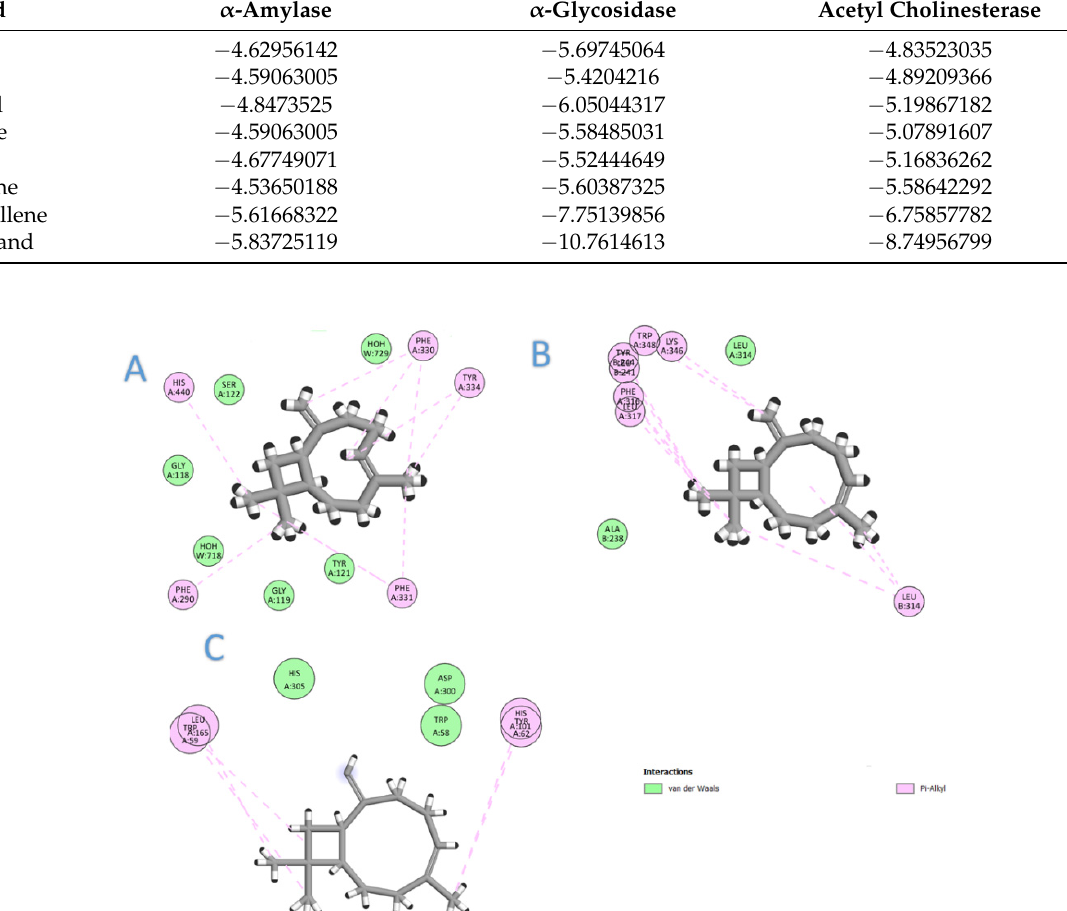
Table 2. The docking scores achieved by the major identified compounds against different enzymes. Compound